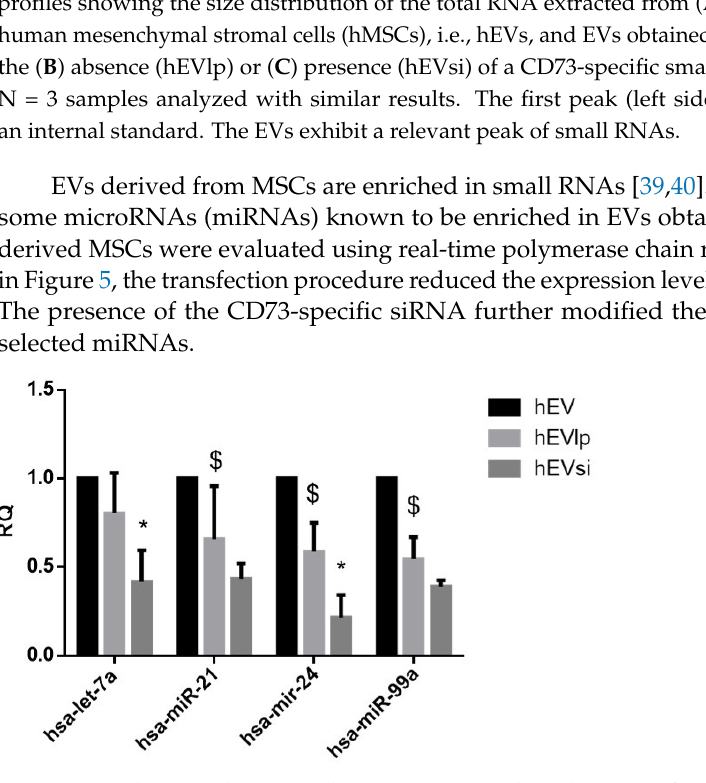
Figure 5. Real-time polymerase chain reaction (PCR) analyses. Analyses of the expression levels of selected microRNAs (miRNAs), specifically, hsa-let-7a, hsa-mir-21, hsa-mir-24, and hsa-mir-99a, in extracellular vesicles (EVs) from naïve human mesenchymal stromal cells (hMSCs), denoted as hEVs, and EVs from hMSCs transfected in the absence (hEVlp) or presence (hEVsi) of a CD73-specific small interfering RNA (siRNA). The data are normalized with respect to the expression level of miRNAs in hEVs. * p < 0.01 hEVs vs. hEVlp; $ p < 0.05 hEVs vs. hEVsi. N = 3 samples analyzed with similar results.